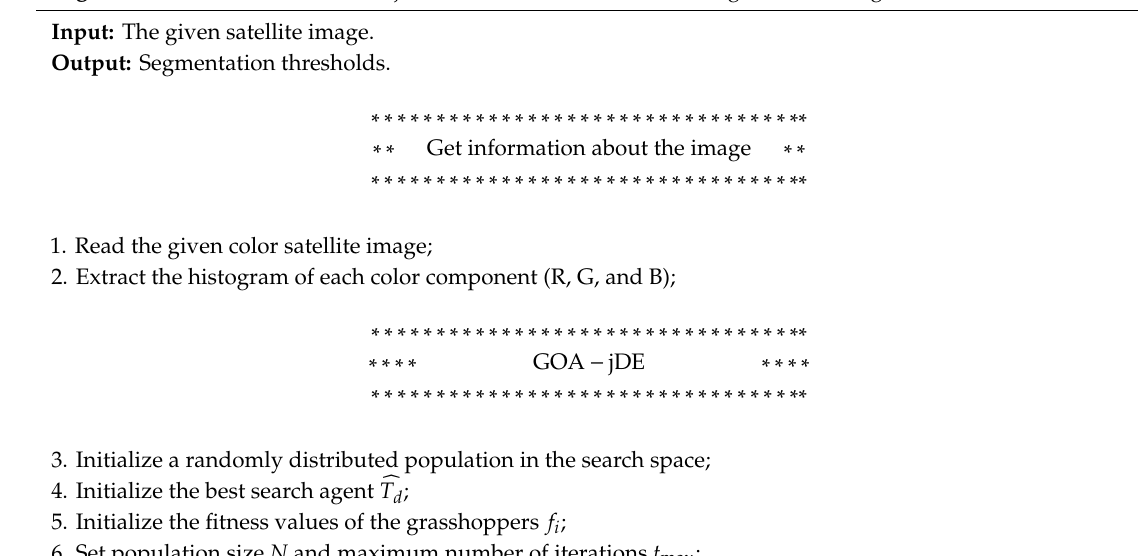
Algorithm 3 Pseudocode of GOA–jDE-based multilevel satellite image